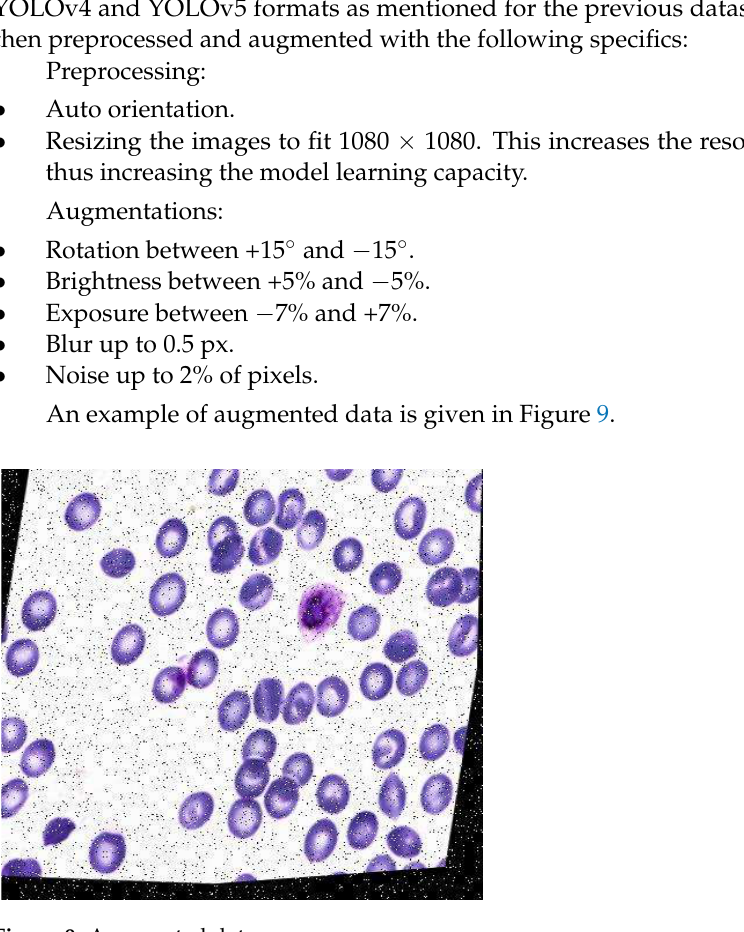
Figure 9. Augmented data.